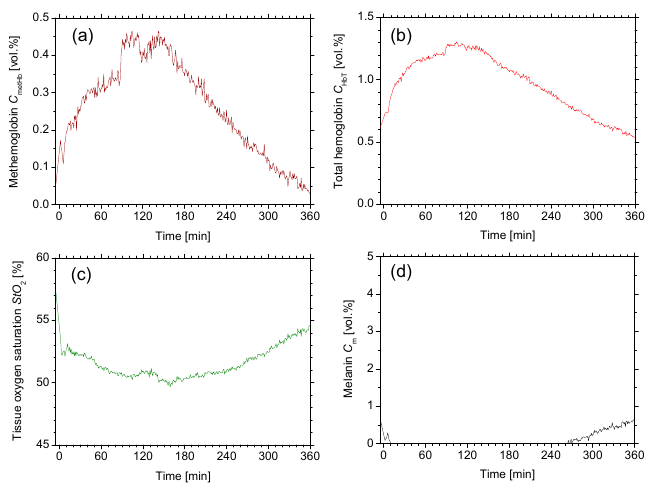
Figure 5. Typical time courses of ( a ) C metHb , ( b ) C HbT , ( c ) StO 2 , and ( d ) C m averaged over entire region of each estimated image.